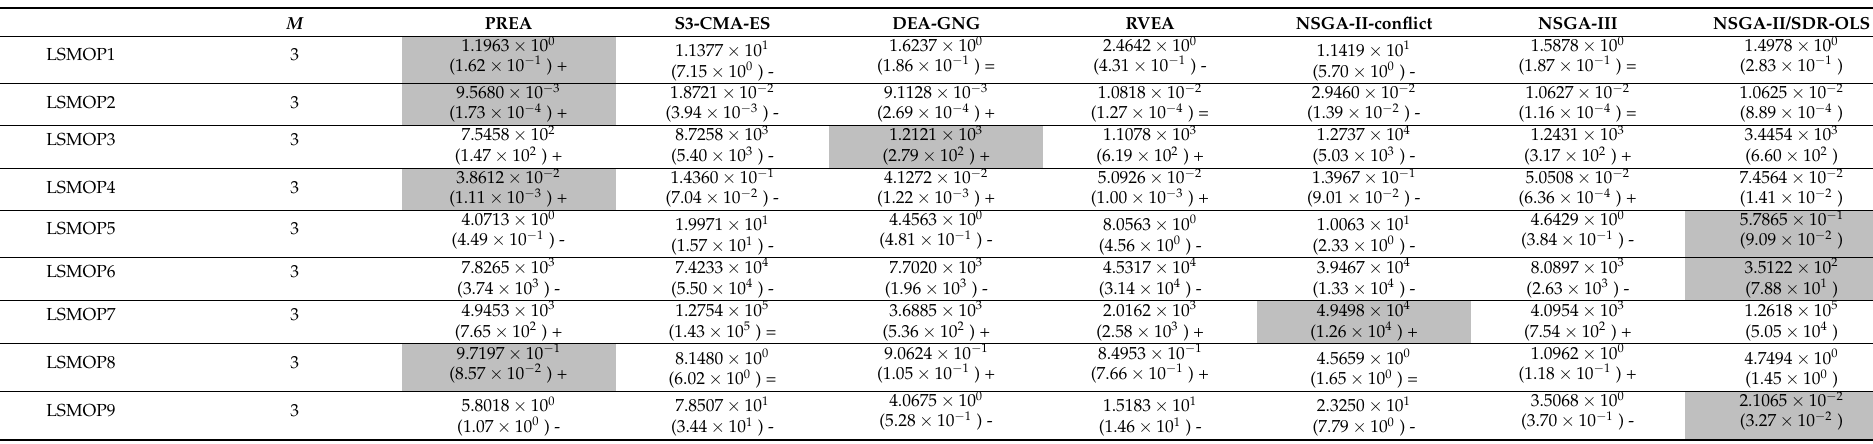
The gray background represents that this algorithm has the best performance on this problem. The number in the brackets represents the standard deviation, and the number out of the brackets represents the mean values. “+/-/=” means that the relevant algorithm performs better than/worse than/as well as the NSGA-II/SDR-OLS algorithm. Same below table. Table 7. GD values for 9 three-objective benchmark